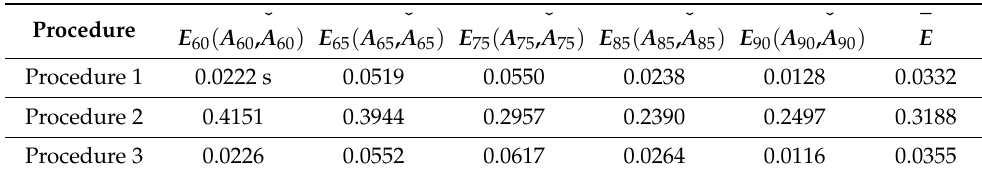
and ˇ A sp (procedures 1, 2, and 1 1